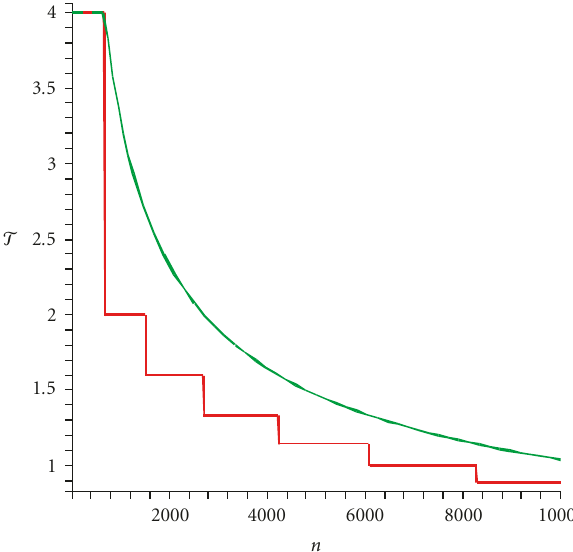
Figure 11: Throughput T versus n (upper and lower bounds) for beamwidth of 15 degrees.